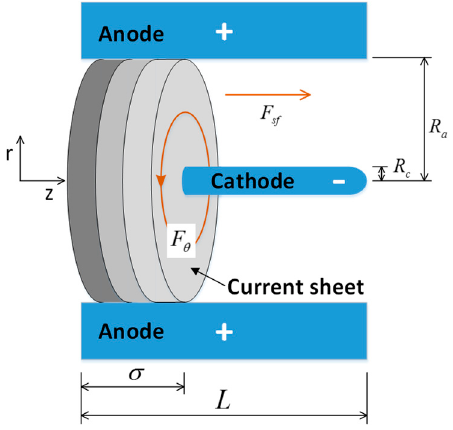
Figure 2. Elements of the electromechanical model.